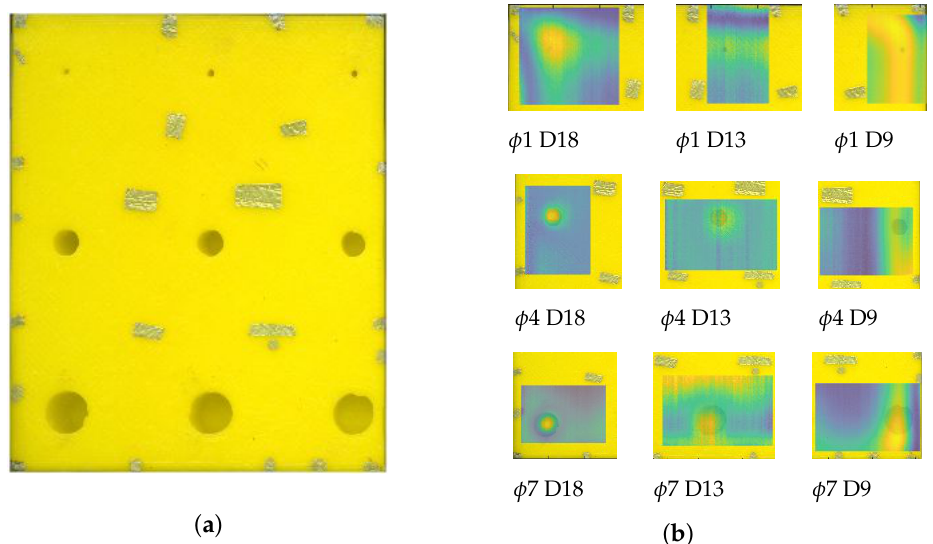
Figure 9. The results of defect visualisation for defects φ 7 and different D values: 1—raw thermogram (captured after the heating phase t = 60 s), 2—chosen result from sequence A I , 3—chosen result from sequence A D , and 4—chosen result from sequence A Res .